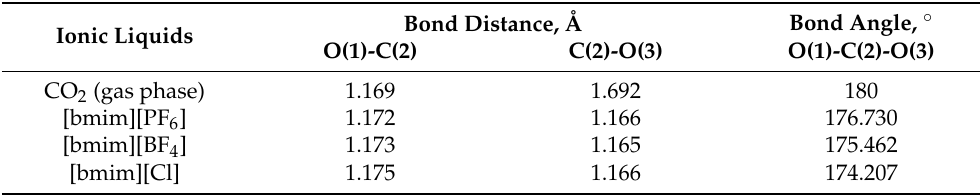
Figure 6. Scheme of ionic liquid (IL) promoted catalytic reaction process, as proposed by Du et al. [61]. (Reprinted with permission from Ref. [61], 2012, Elsevier). Table 2. Effects of ionic liquids on bond distances and bond angles of CO 2 [61]. (Adapted with permission from Ref. [61], 2012,